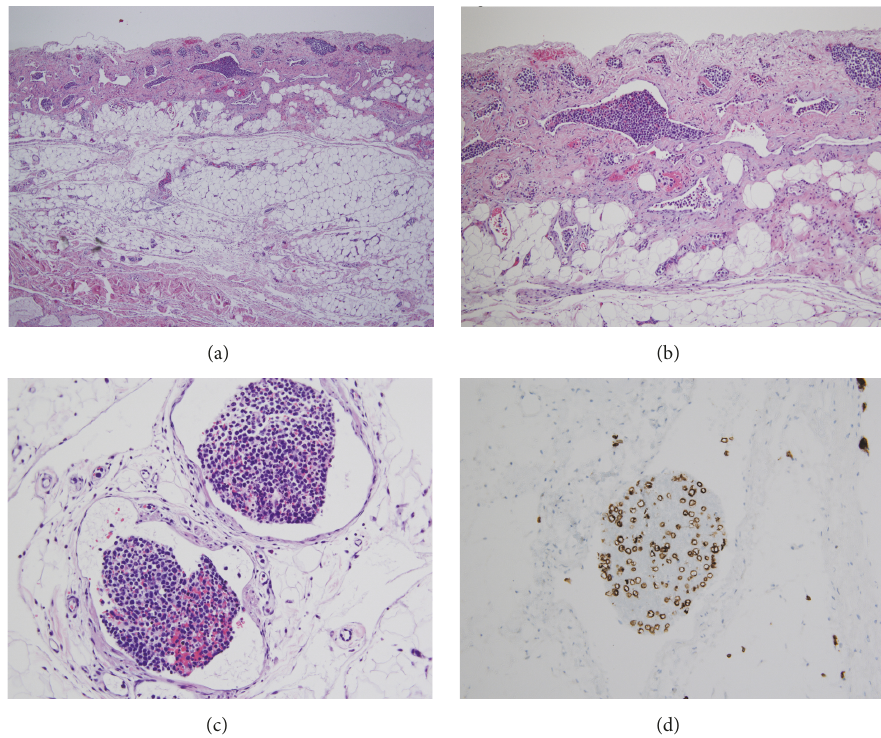
Figure5:Microscopicimagesshowgallbladderwallthickeningandlymphaticectasia.Severalbloodvesselsinthesubserosalfatareinfiltrated with large, atypical lymphomatous cells. The mucosa is uninvolved. Immunohistochemical stain with CD79a confirms B-cell origin.